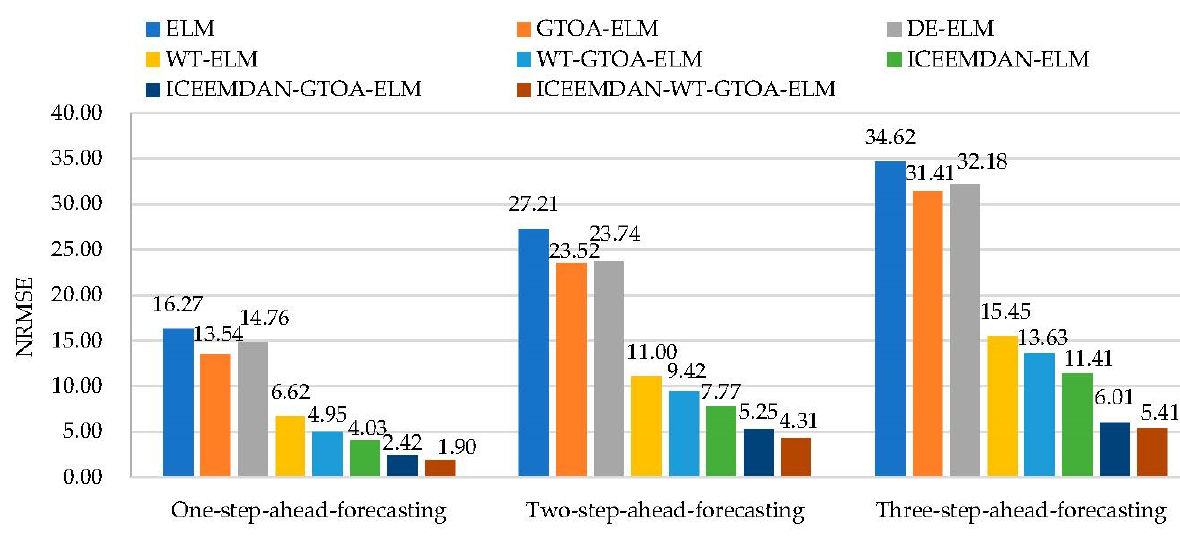
Figure 11. NRMSE of PM2.5 forecasting.